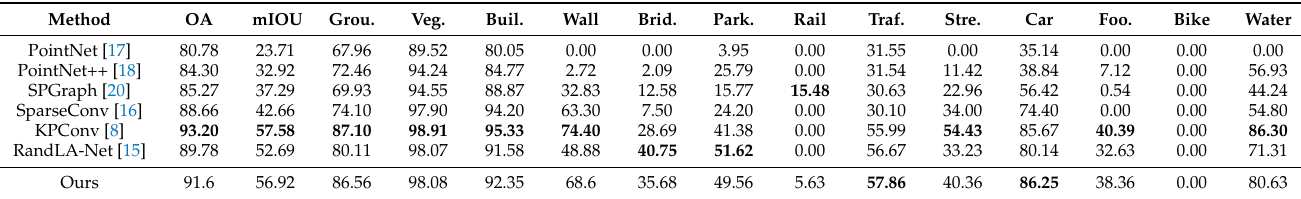
Table 5. Semantic segmentation results for SensatUrban.